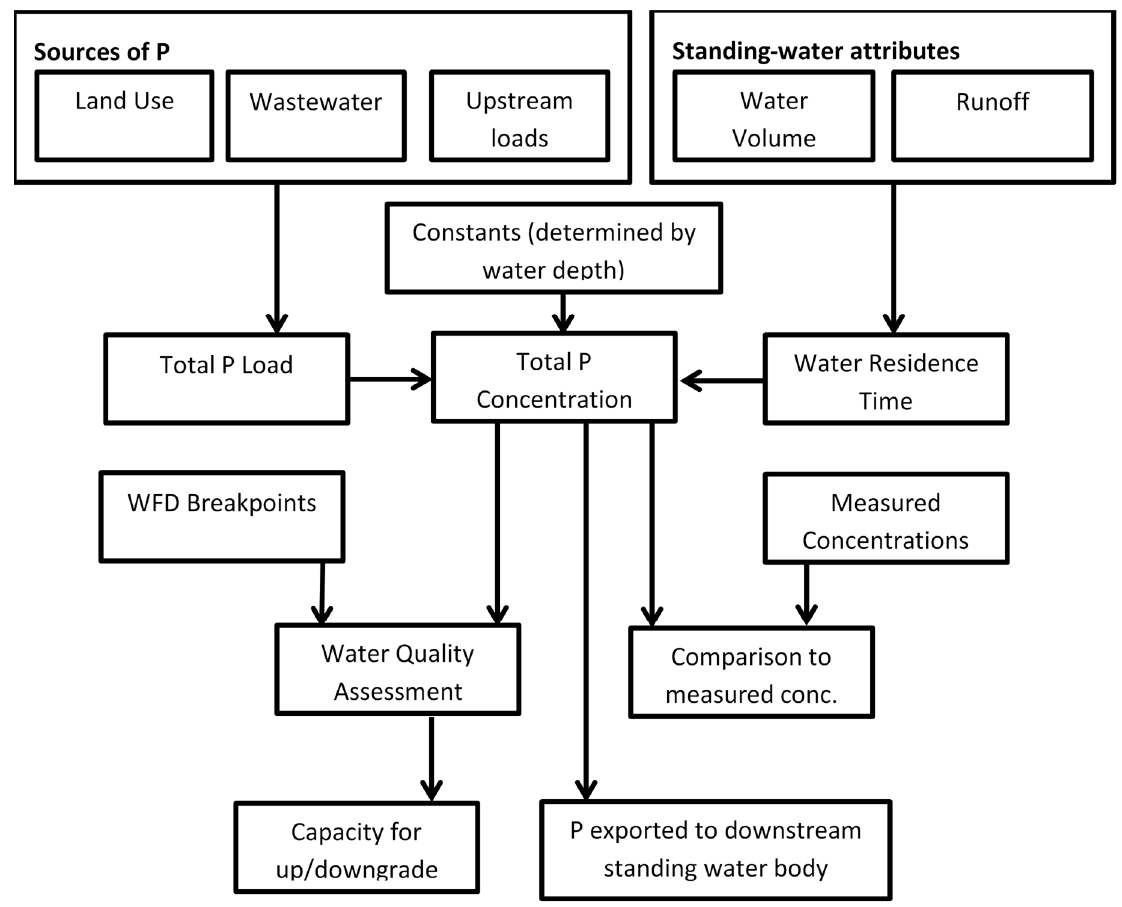
Figure 2. Schematic diagram of the main stores, processes and pathways included in the PLUS+ tool.